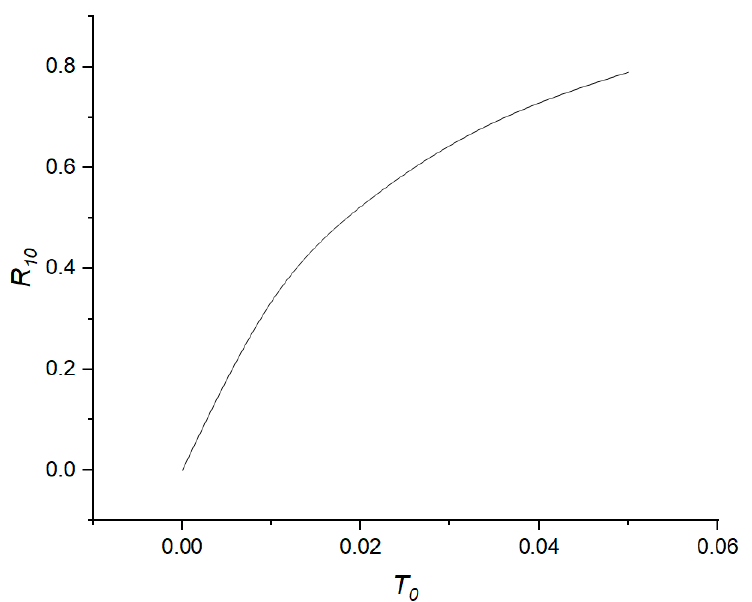
Figure 5. Calculation data on flow profile redistribution R 10 from the dimensionless suspension injected volume T 0 .